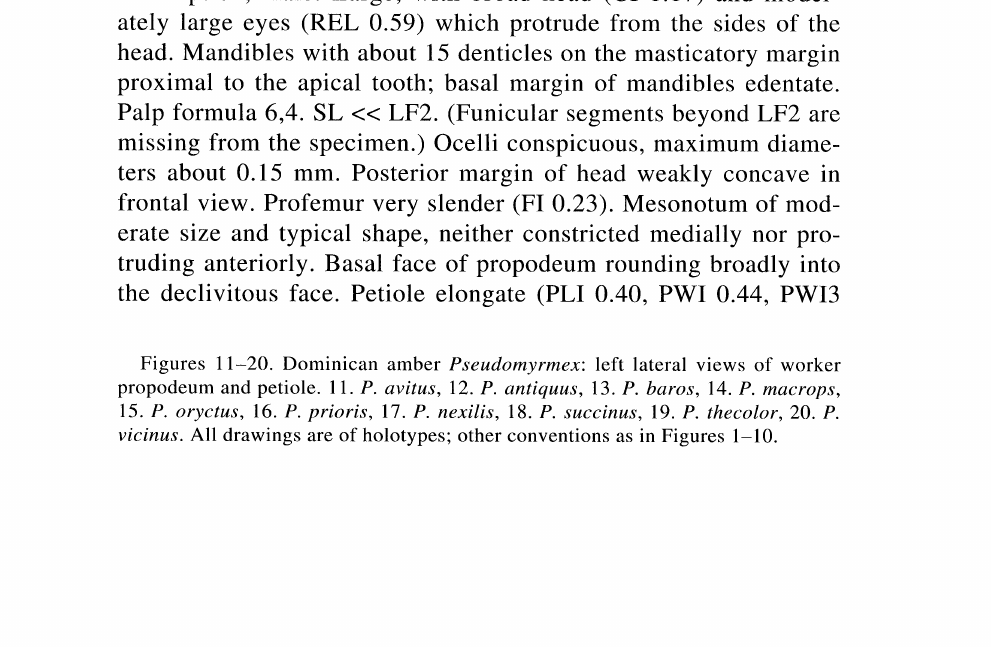
Figures 11-20. Dominican amber Pseudomyrmex: left lateral views of worker propodeum and petiole. 11. P. avitus, 12. P. antiquus, 13. P. baros, 14. P. macrops, 15. P. oryctus, 16. P. prioris, 17. P. nexilis, 18. P. succinus, 19. P. thecolor, 20. P. vicinus. All drawings are of holotypes; other conventions as in Figures